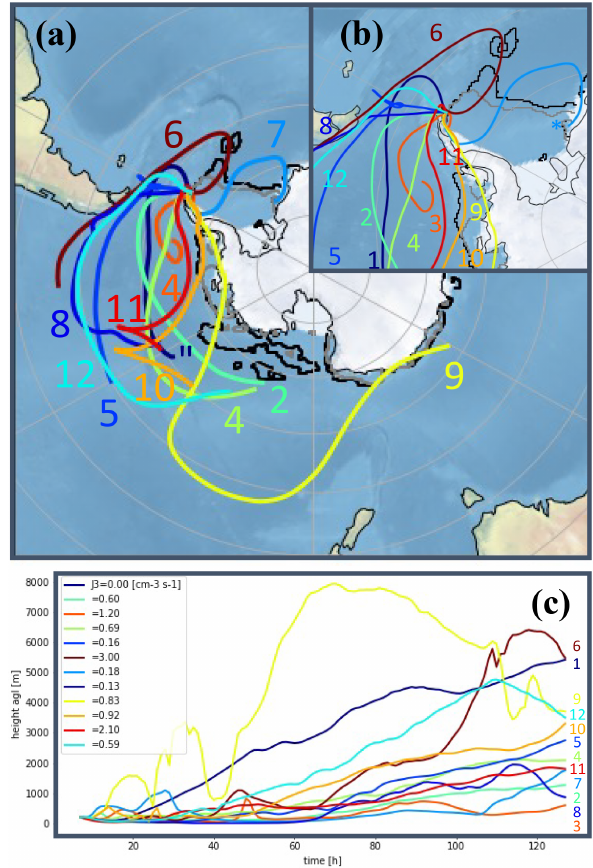
Figure 9. Backward trajectories for recorded NPF events (a) (num- bering according to classification in Table 1). Panel (b) shows a zoomed-in view over the Antarctic Peninsula, and panel (c) shows the trajectory altitudes colored by formation rate J 3 values. In pan- els (a) and (b) the black and gray lines delimit the sea ice ex- tent as an average for January and February 2018, respectively. Sea ice data are from ftp://sidads.colorado.edu/DATASETS/NOAA/ G02135/south/monthly/ (last access: 5 August 2021; Fetterer et al.,